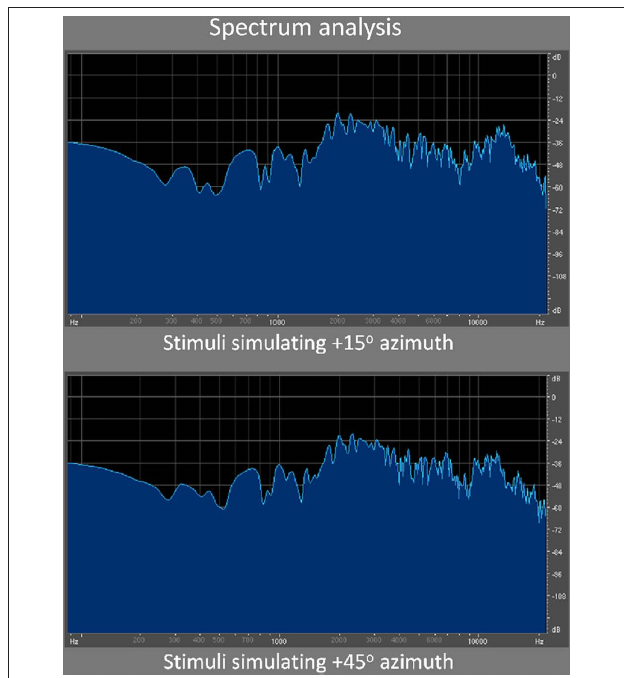
FigurE 1 | Spectrum analysis. Here are illustrated the spectrograms of two sample stimuli used in the discrimination task. Specifically, these two stimuli were often compared to one another when the reference (first) stimulus was simulating + 15 ° azimuth. As can be seen, the differences in spectral content between both sounds are very subtle, consistent with the difficulty level of the